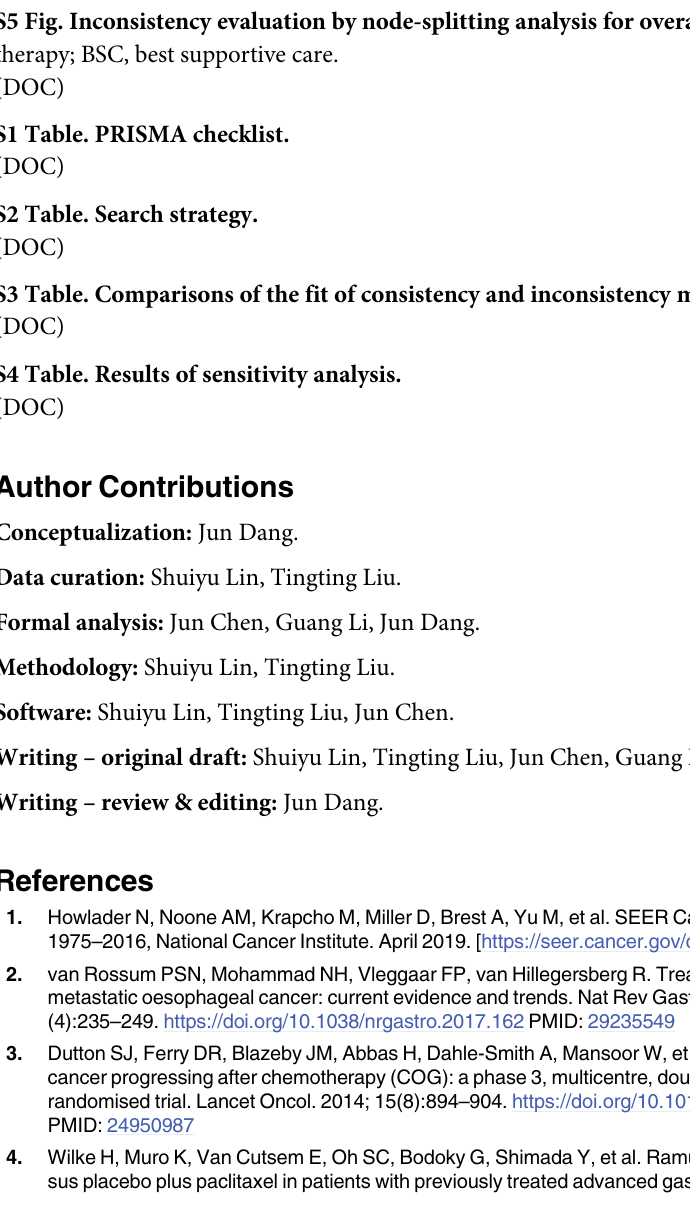
S3 Fig. Treatment ranking curves based on SUCRA. OS, overall survival; PFS, progression- free survival; ORR, objective response rate; SAE, serious adverse event; SUCRA, surface under the cumulative ranking; T-DXd, trastuzumab deruxtecan; CT, chemotherapy; BSC, best sup- portive care. S4 Fig. Assessment of transitivity among included trials. a, sample size; b, median age; c, median follow up time. T-DXd, trastuzumab deruxtecan; CT, chemotherapy; BSC, best sup- portive care. S5 Fig. Inconsistency evaluation by node-splitting analysis for overall survival. CT, chemo- therapy; BSC, best supportive care. S1 Table. PRISMA checklist. S2 Table. Search strategy. S3 Table. Comparisons of the fit of consistency and inconsistency models. S4 Table. Results of sensitivity